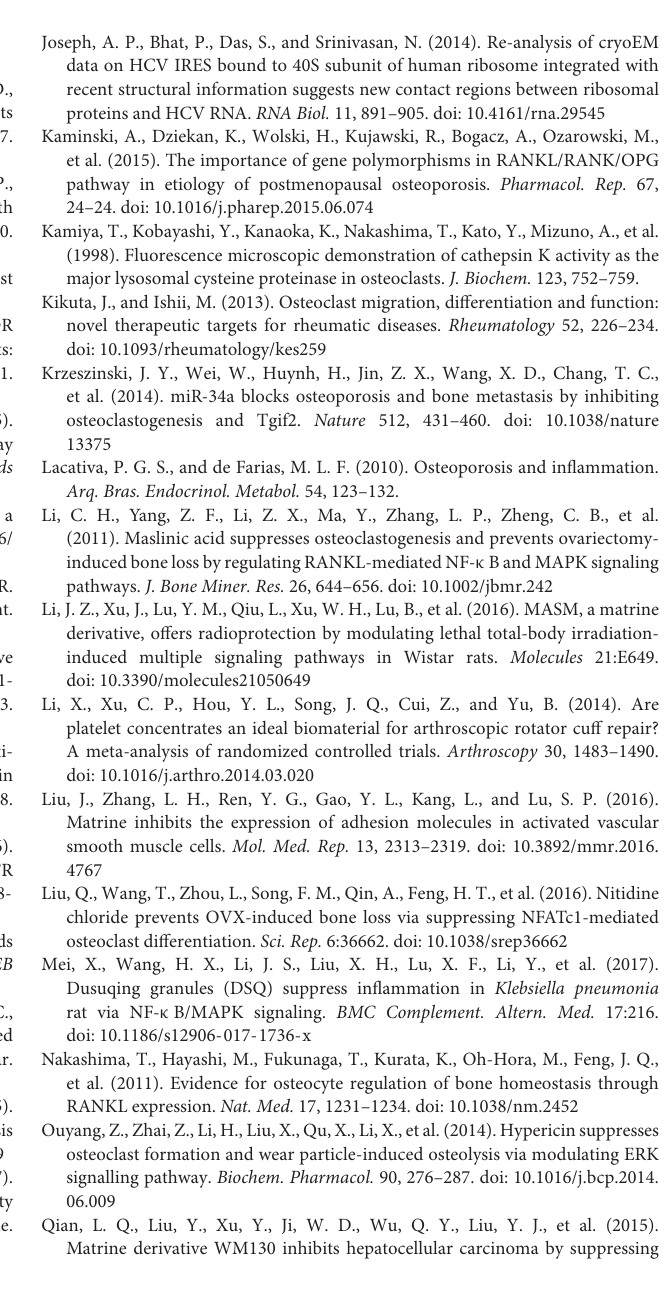
FIGURE S1 | M54 can not inhibits osteogenesis in vitro . FIGURE S2 | M54 showed less cytotoxicity than M19. FIGURE S3 | The inhibiting osteoclastogenesis effect of M54 was more significant than